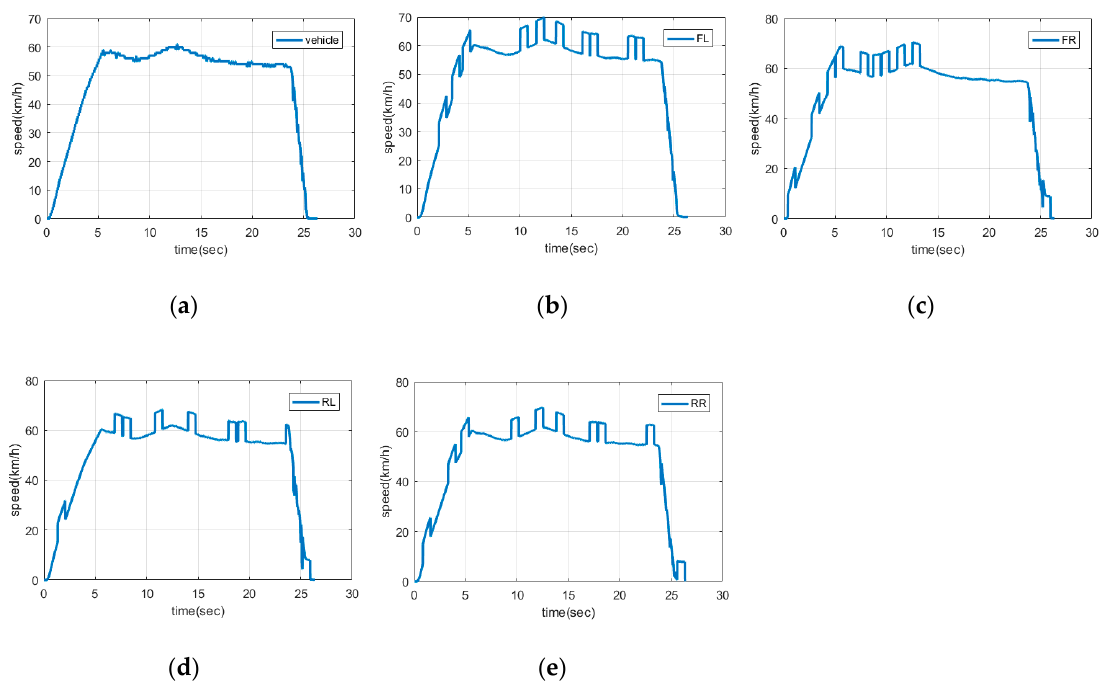
Figure 2. Validation dataset: ( a ) Vehicle speed; ( b ) Front left wheel speed; ( c ) Front right wheel speed; ( d ) Rear left wheel speed; ( e ) Rear right wheel speed.